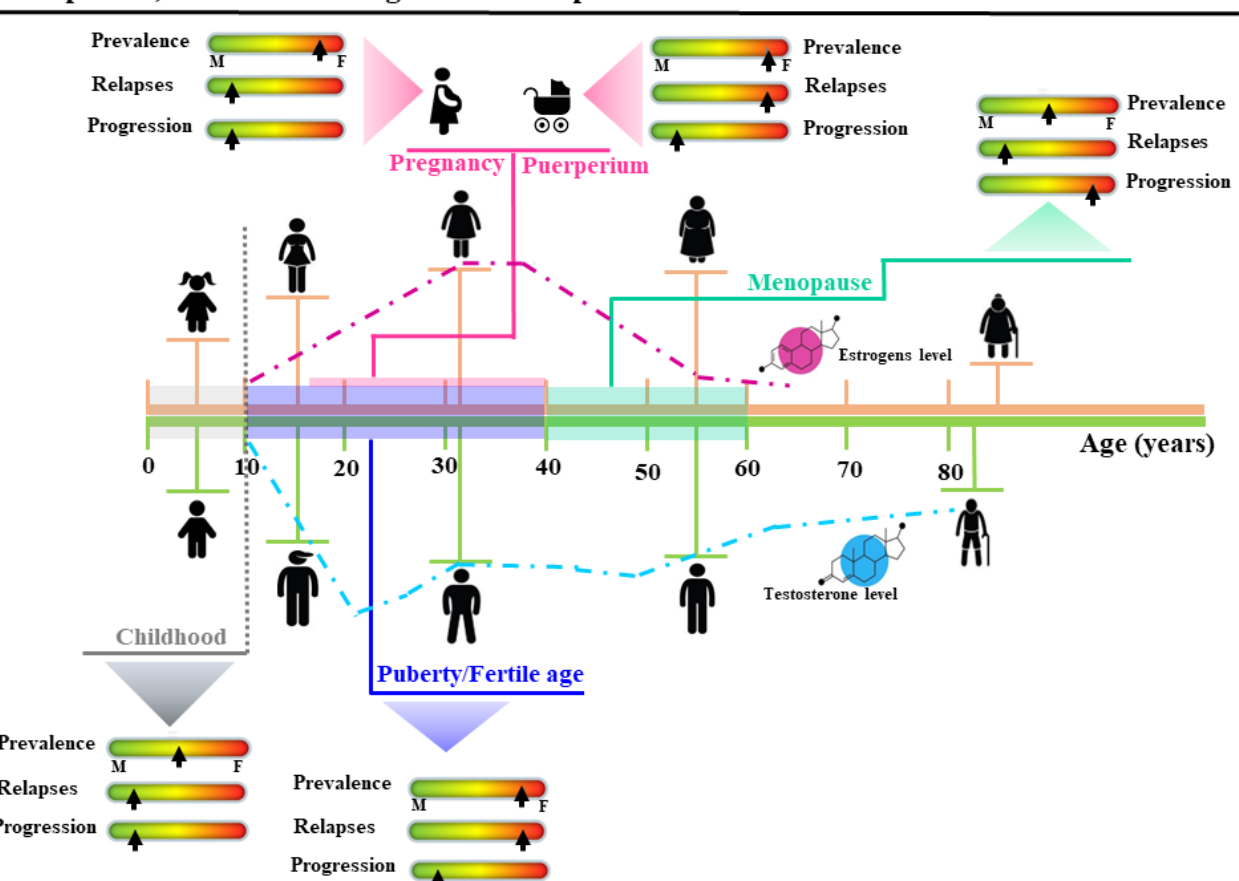
Figure 2. Summary of the effects of the hormonal changes on the prevalence, relapse, and progression of the multiple sclerosis (MS) during the different life phases. Before puberty (age 10 years), MS prevalence is similar between male and females. After menarche, in line with the increase of the estrogens level, prevalence in girls is three times higher. During the fertile age, female predominance remains and relapses are shown in both sexes, but during pregnancy, a significant decrease in female relapse rates (about 70%) is observed, especially in the third trimester. After delivery during the puerperium, relapse rates increase to three times higher than pre-pregnancy levels. Worsening of symptoms and progression of MS have been shown in menopause.